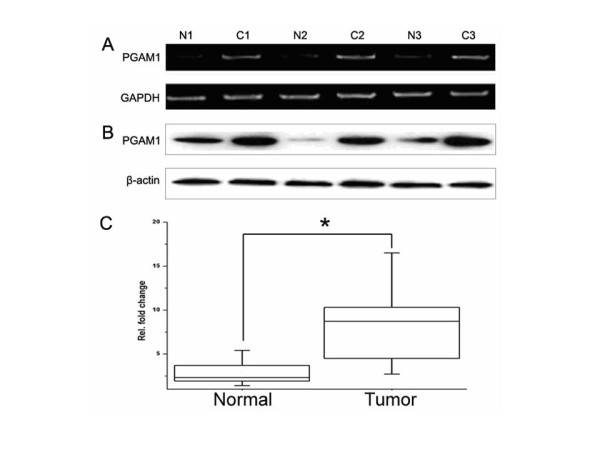
Overexpression of PGAM1 in HCCs. (A), expression level of PGAM1 mRNA was semi-quantified by RT-PCR. Pairs of the total mRNA were normalized by GAPDH. (B), representative results of Western blot analysis of HCCs and the adjacent noncancerous samples with β--actin as an internal control. (C), box chart, quantitative Western blot results of HCCs vs. the corresponding normal tissues. To ensure reproducibility, three independent experiments were performed. *, p < 0.01, Student's t test. N, normal liver tissue. C, cancer tissue.